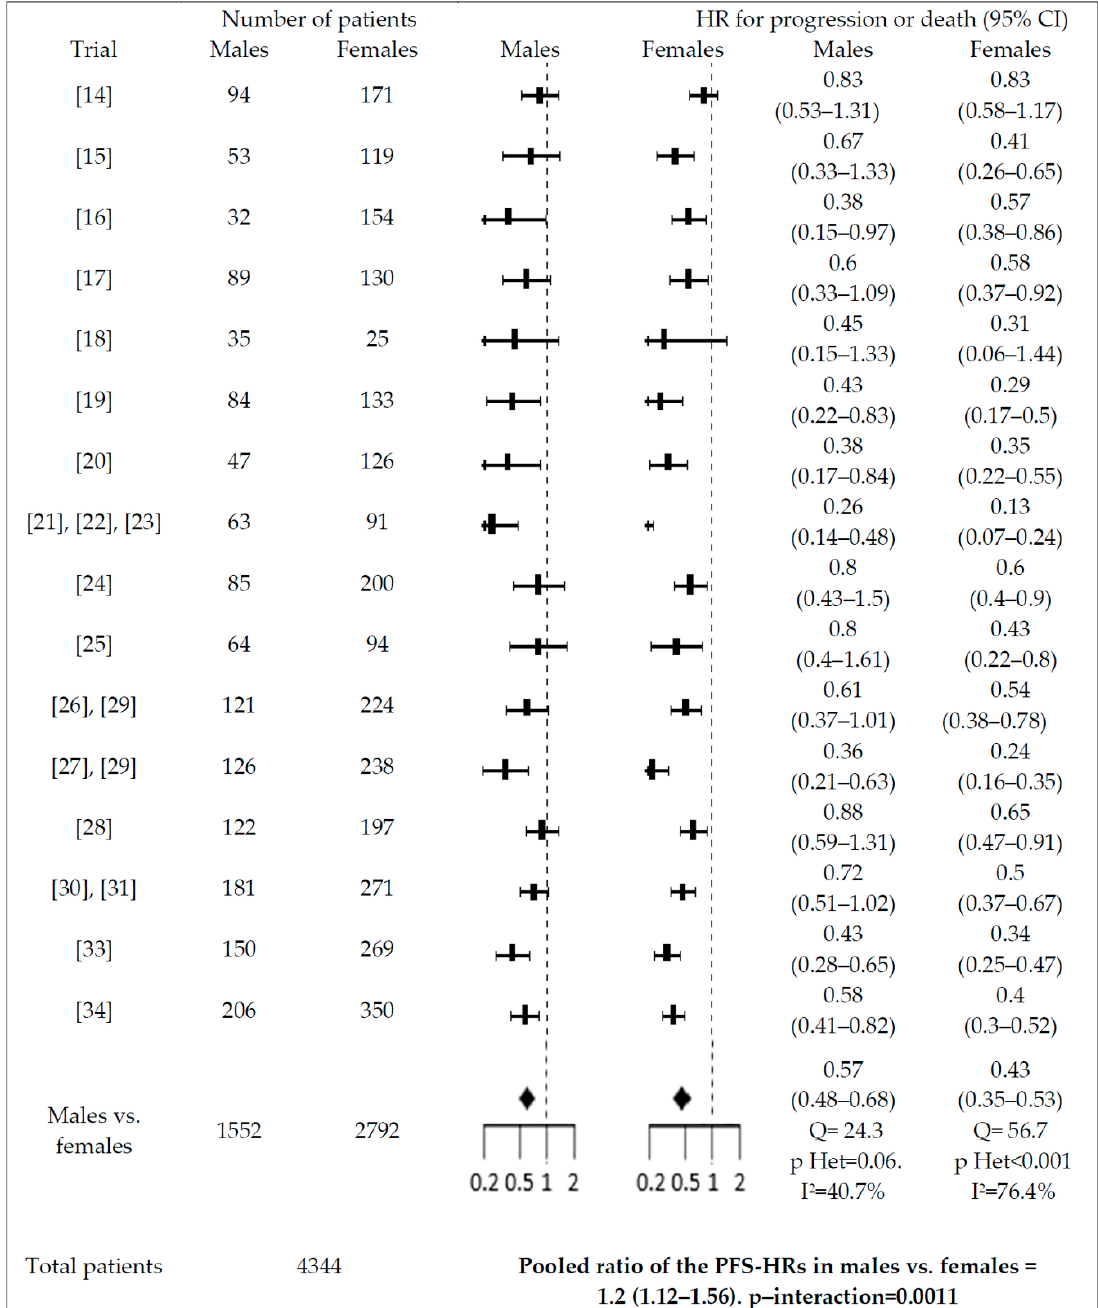
Figure 3. Interaction between PFS-HR and sex. PFS-HRs are separately reported for males vs. females. Pooled PFS-HRs in males and females and pooled ratio of the PFS-HRs in males vs. females are reported at the bottom of the figure.